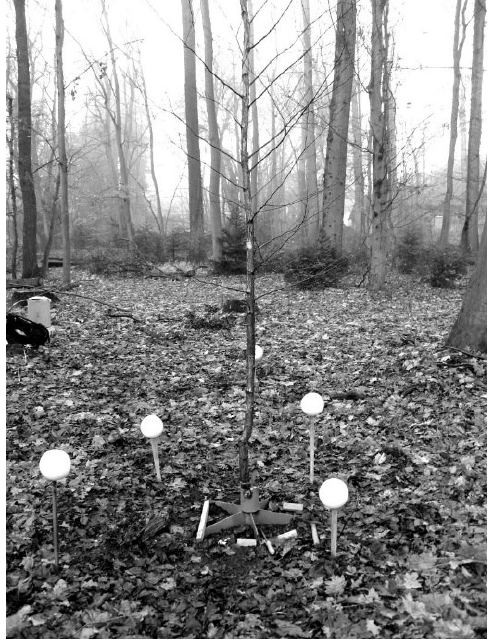
Figure 1. Tree no. 1 of Betula mounted on a stand. The four reference spheres inside the scan area can be clearly seen in the foreground, and one of the four reference spheres outside the scan area is visible behind the